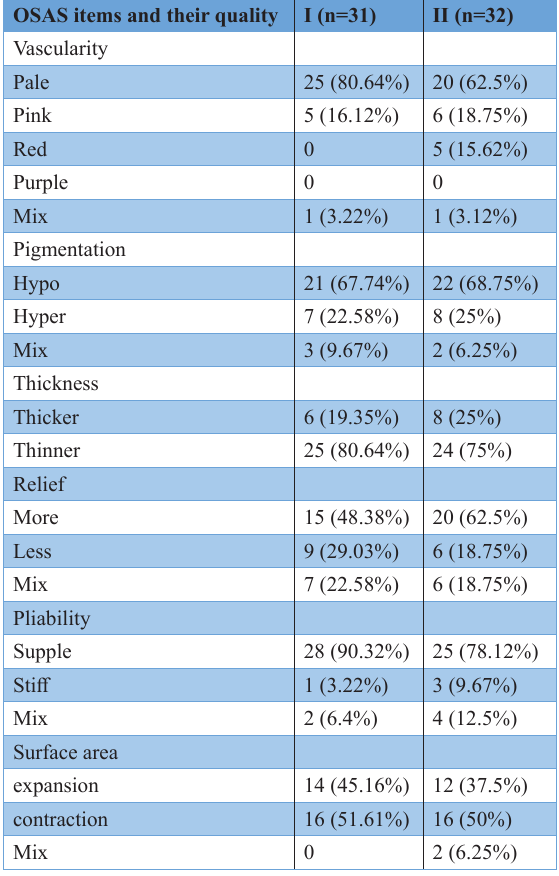
by pigmentation in group I, and relief in group II owing